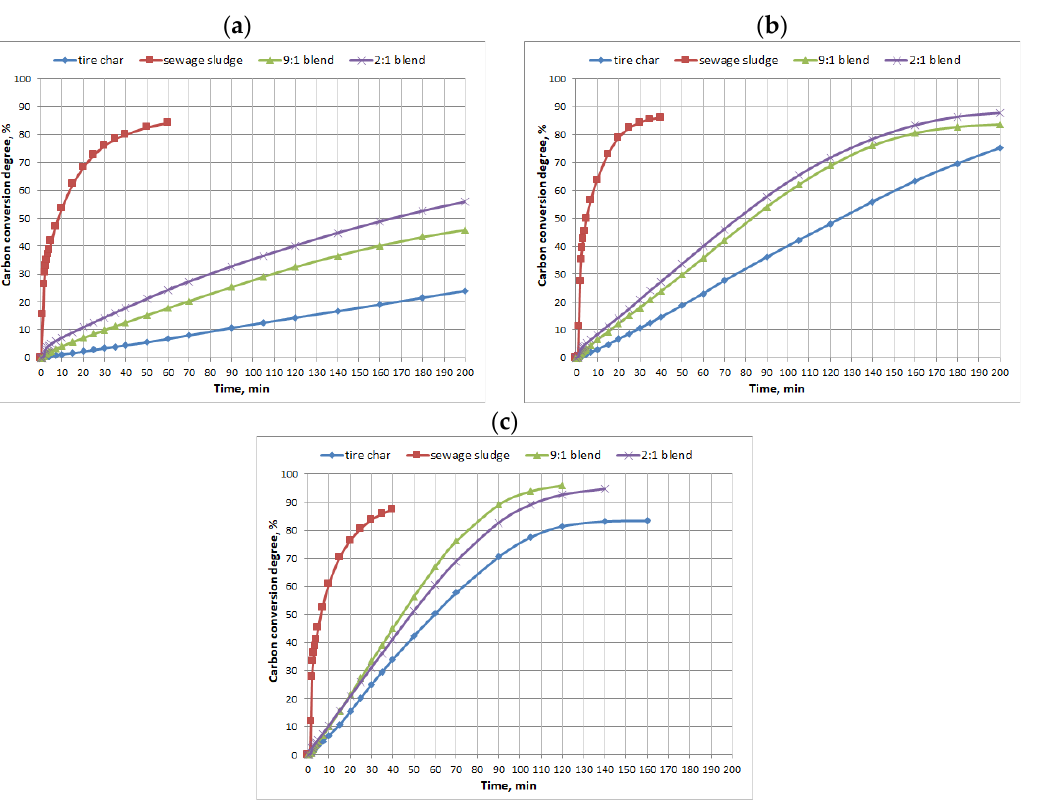
Figure 3. Changes in carbon conversion during steam gasification at ( a ) 800 °C, ( b ) 850 °C, and ( c ) 900 °C.